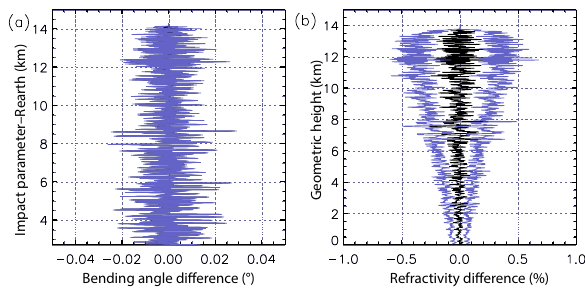
Figure 5. (a) Mean (black) and standard deviation of FSI-retrieved bending angle error given 1% Gaussian refractivity error at the re- ceiver. (b) Same as (a) but for fractional refractivity